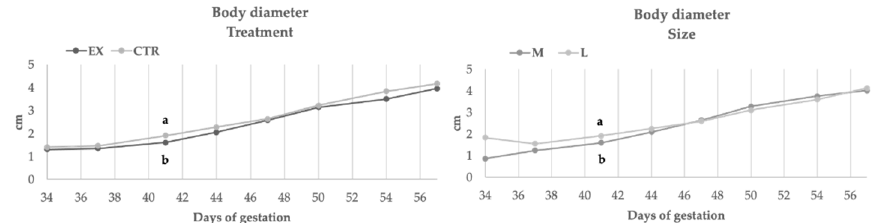
Figure 4. Body diameter during gestation in function of diets and size. EX: experimental group CTR: control group; a, b: p < 0.05.